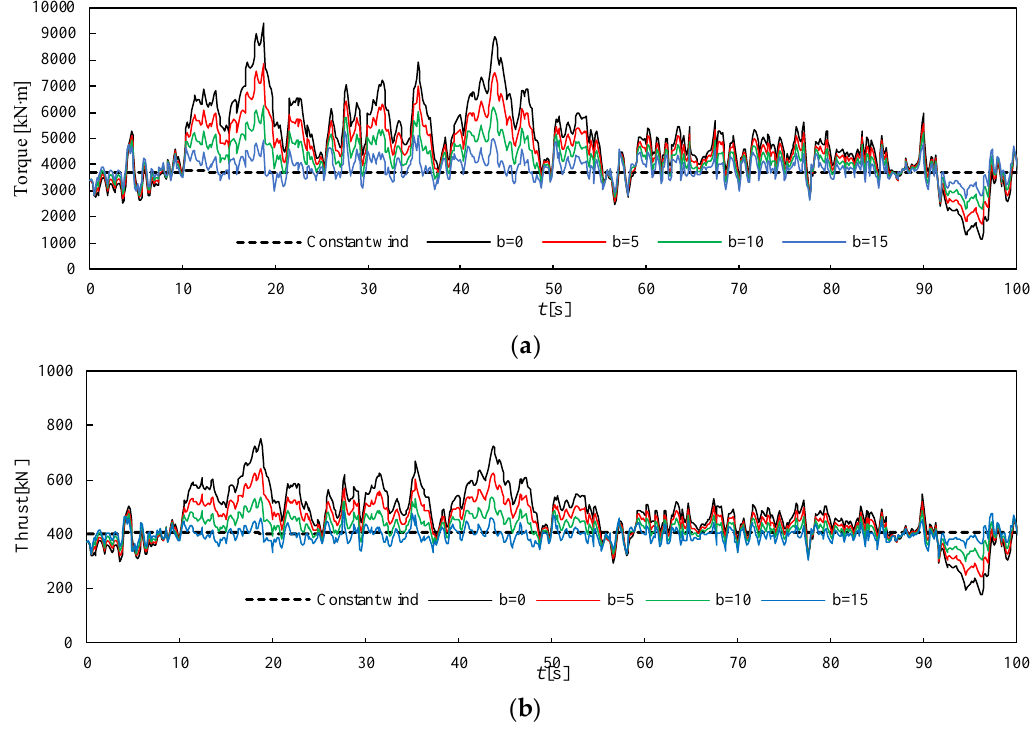
Figure 18. Torque and thrust response of the wind turbine rotor under turbulent wind conditions for U mean = 16 m/s and θ p = 10.5°. ( a ) Torque response; ( b ) thrust response.